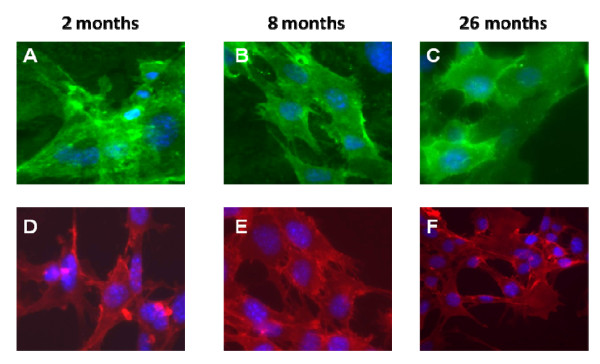
Expression of stem cell markers.  Immunofluoresence of isolated bone marrow stem cells.  Isolated MSC passage 11 were fixed and stained with anti-Sca-1 and CD44 antibodies.  All cells were positive for these stem cell markers.